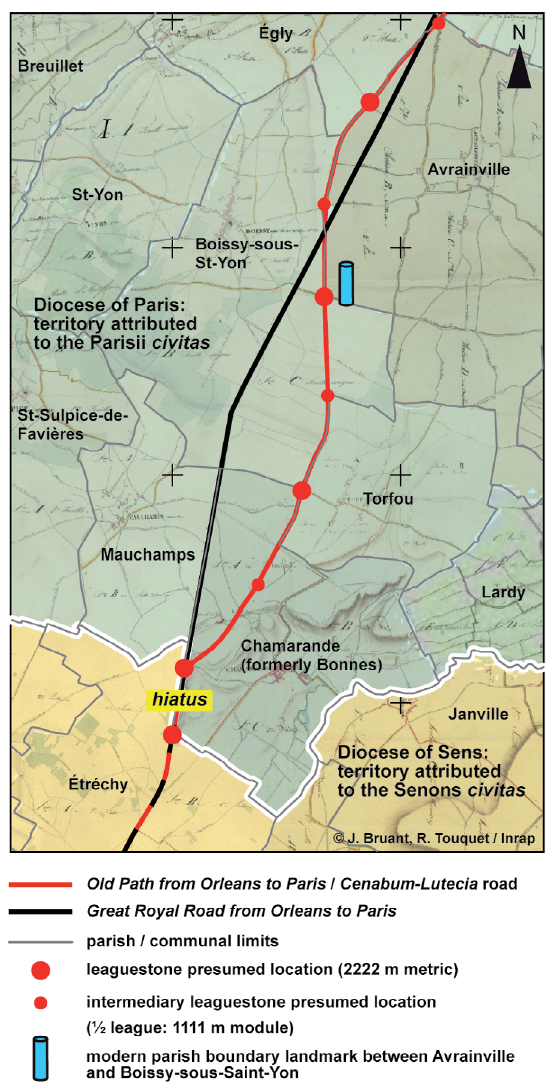
Figure 7. Traces of landmarks on the Old Path from Orleans to Paris showing a hiatus between the supposed territories of the Parisii and the Senons (orthorectified napoleonian cadastre) © J. Bruant, R. Touquet/Inrap.